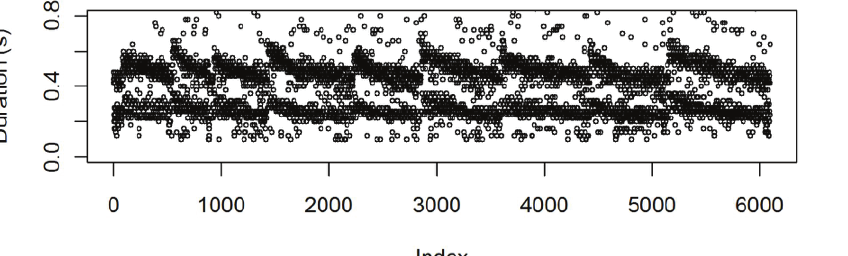
Figure 3: Time intervals occurring between the onsets of the notes generated by the accordion’s keyboard of low-pitched sounds. On the x-axis, the index of the onset notes performed by the bass section of the accordion; on the y-axis, the IOI (inter-onset-interval) between each note onset and the following, expressed in seconds. The bass notes offer strong evidence of the binary rhythmic trend of the